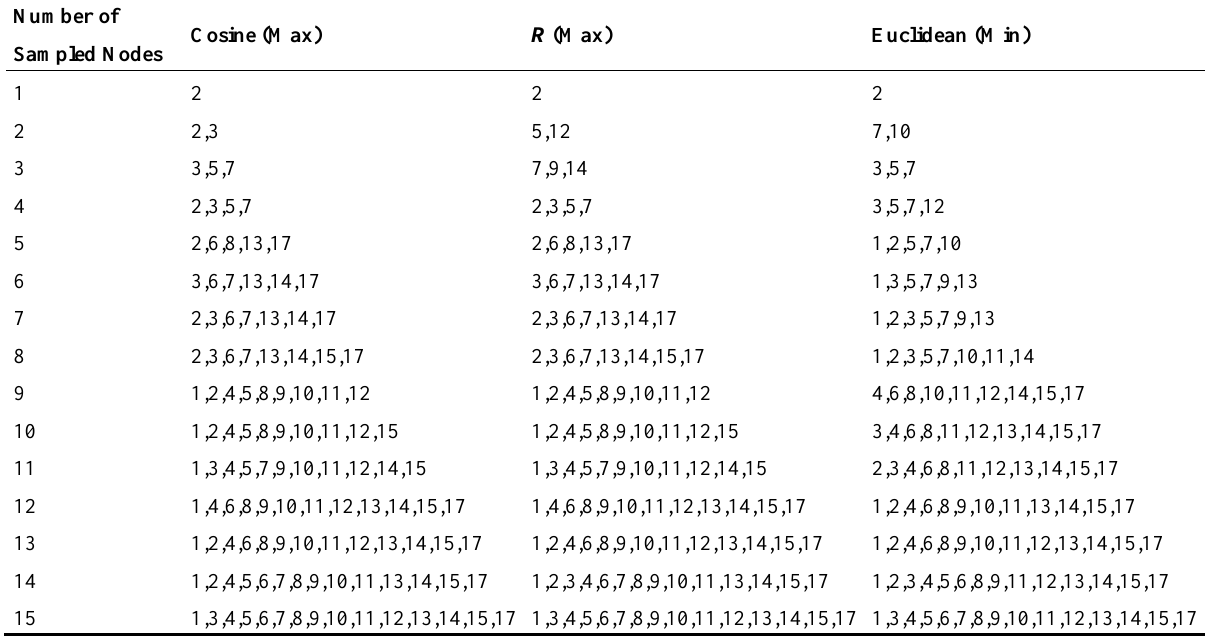
Table 3. The OCN identified by the maximum angular cosine (Cosine), maximum correlation coefficient ( R ) and minimum Euclidean distance (Euclidean) for different number of measurement nodes.